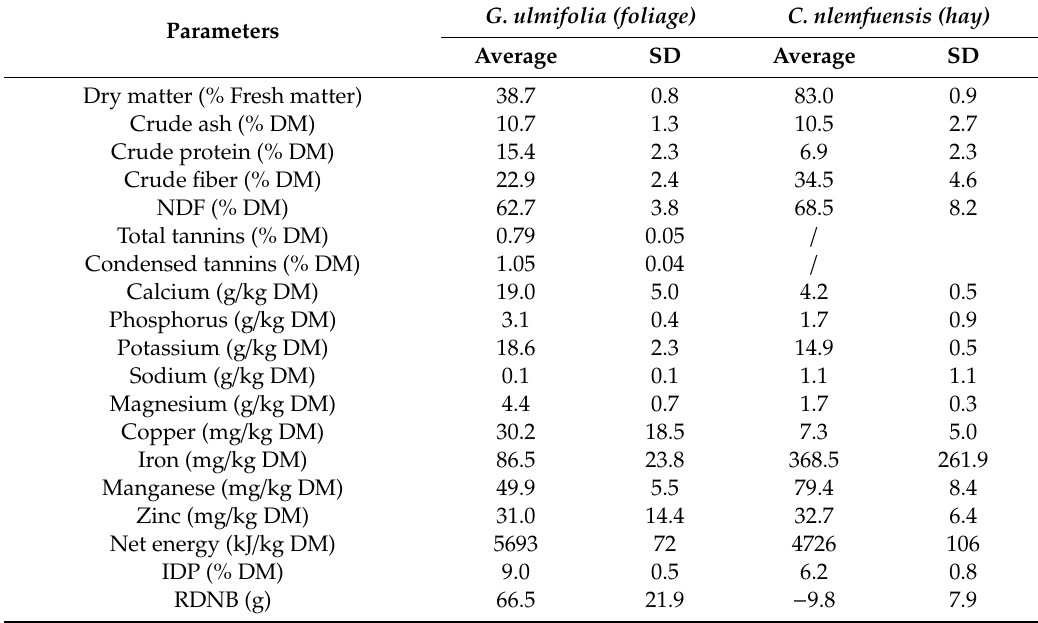
Table 2. Chemical composition, energy, and protein values of G. ulmifolia (fresh foliage) and C. nlemfuensis (hay) o ff ered to